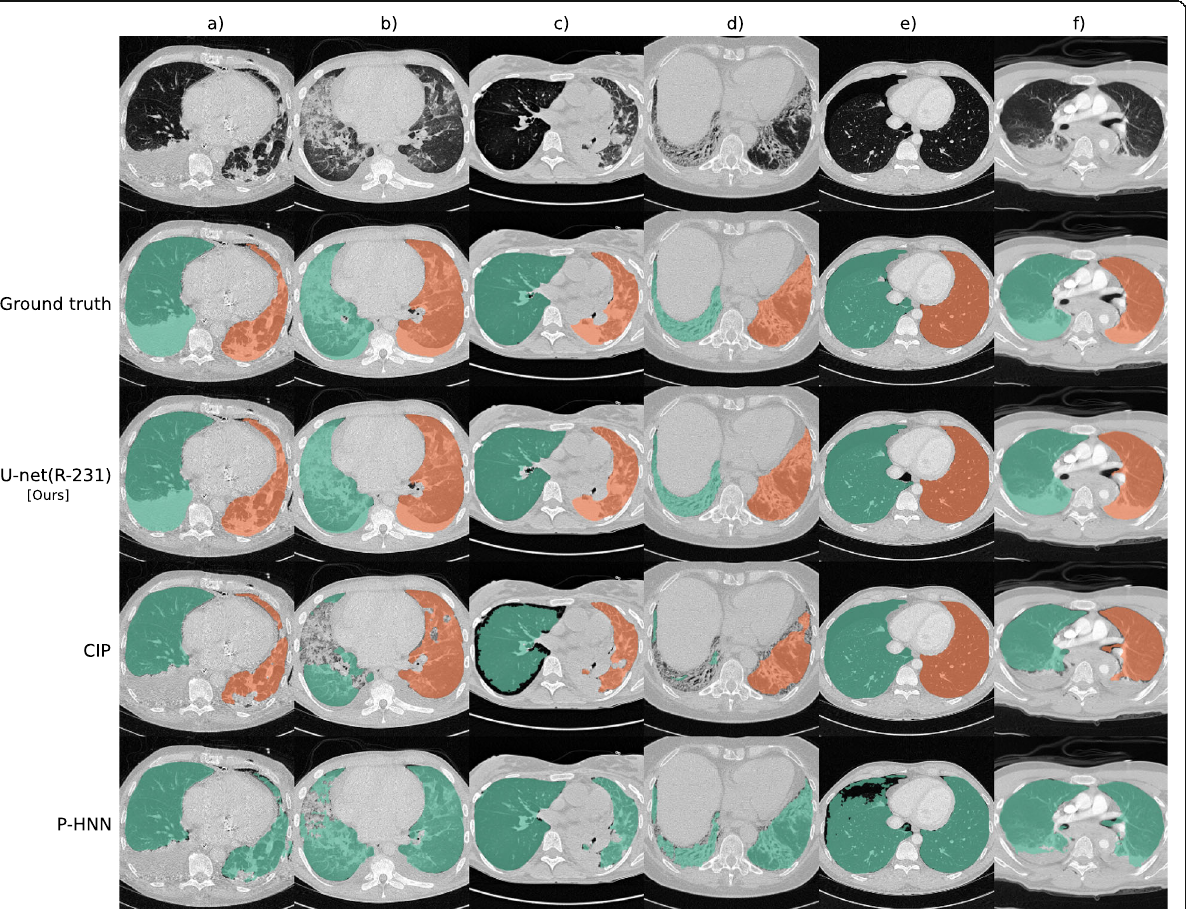
Fig. 2 Segmentation results for selected cases from routine data. Each column shows a different case. Row 1 shows a slice without lung masks, row 2 shows the ground truth, and rows 3 to 5 show automatically generated lung masks. Effusion, chest tube, and consolidations ( a ); small effusions, ground-glass and consolidation ( b ); over-inflated (right) and poorly ventilated (left), atelectasis ( c ); irregular reticulation and traction bronchiectasis, fibrosis ( d ); pneumothorax ( e ); and effusions and compression atelectasis (trauma) ( f